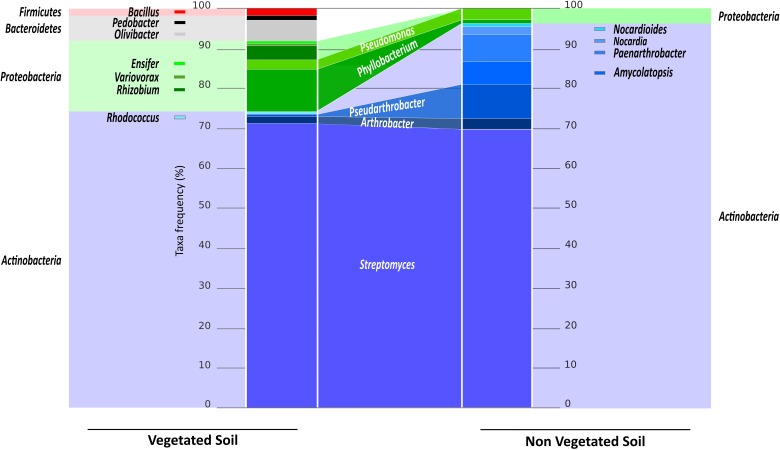
The cultivable bacterial communities from the VS and NVS fractions. The light-colored histograms at the edge represent the abundance of bacterial phyla expressed as a percentage of the total number of bacteria for the VS (Left) and the NVS (Right). The dark-colored central histogram represents the abundance of bacterial genera expressed as a percentage of the total number of bacteria for the VS (Left) and the NVS (Right). The names in white in the center indicate the shared bacteria between the two habitats.